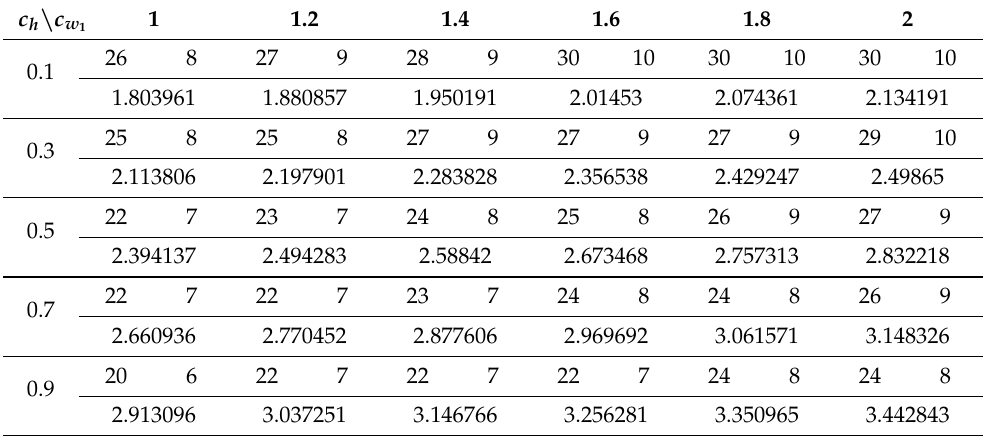
Table 5. Total expected cost c h vs. c w